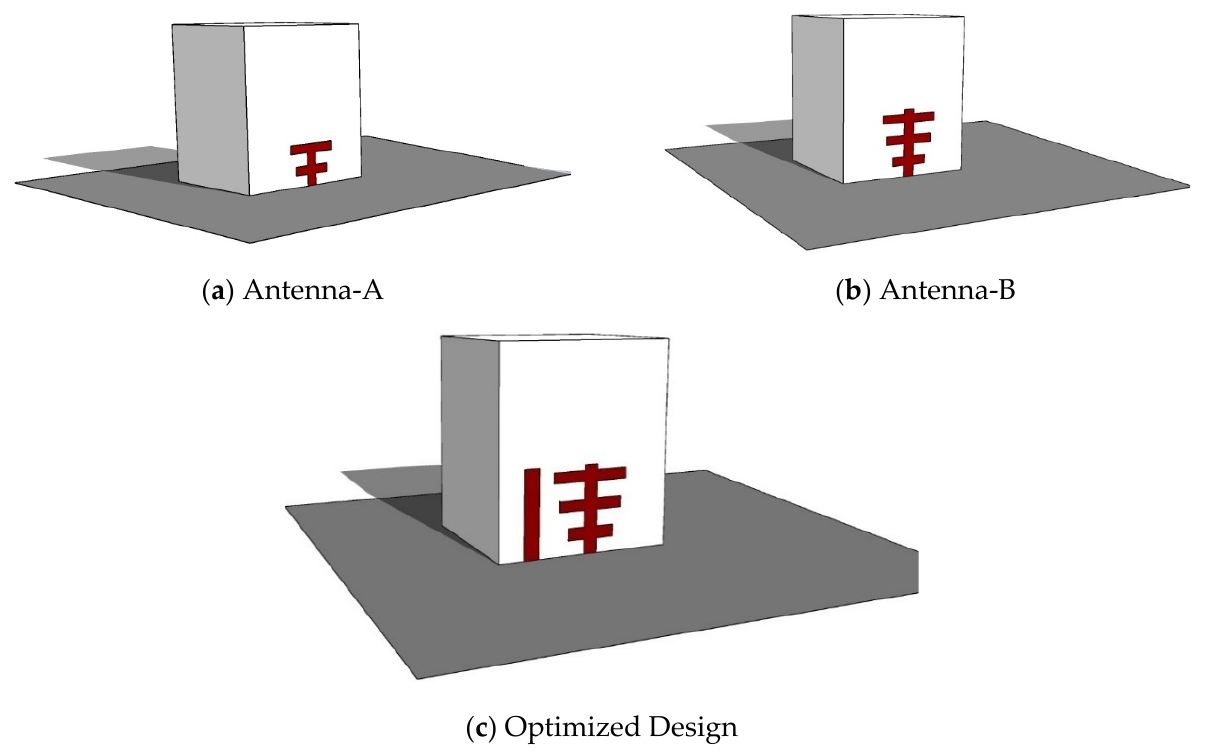
Figure 3. Evolution of the RDRA wideband antenna (3 ‐ D View) ( a ) Antenna ‐ A, RDRA with the T ‐ shape feed; ( b ) antenna ‐ 2, RDRA with a novel flat surface metal strip (Yagi ‐ Uda); ( c ) desired wideband RDRA with the parasitic patch.